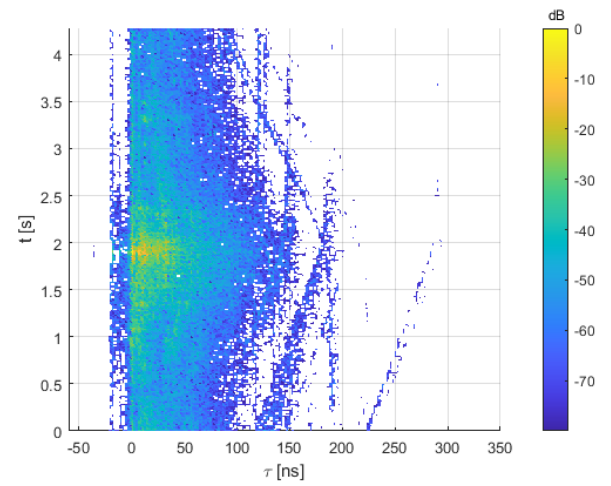
Figure 14. Measured PDPs shifted to align the main component.